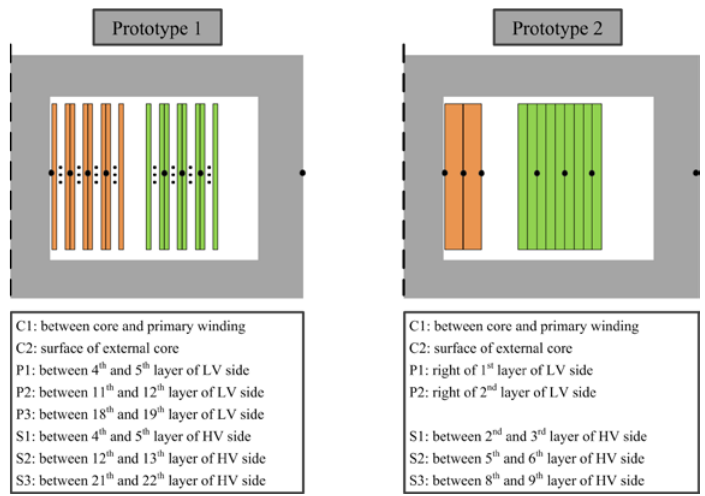
Figure 3. Experimental setup for validation.